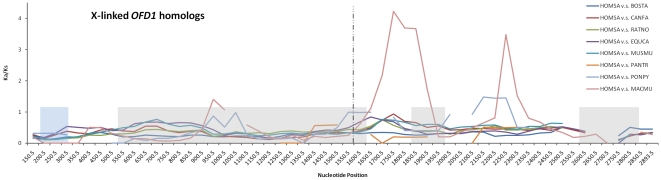
Sliding window analysis of Ka/Ks ratio along the OFD1 protein.Sliding window analysis of Ka/Ks ratio was performed by comparing human OFD1X sequence with other eutherian OFD1X sequences (300 bp window, 50 bp slide). The vertical line represents the position of 1600 nt. Ka/Ks ratio is plotted against the length of the coding region of the mRNAs with a highlighted presentation of protein domains along the x-axis (blue: LisH domain; grey: coiled-coil domains).